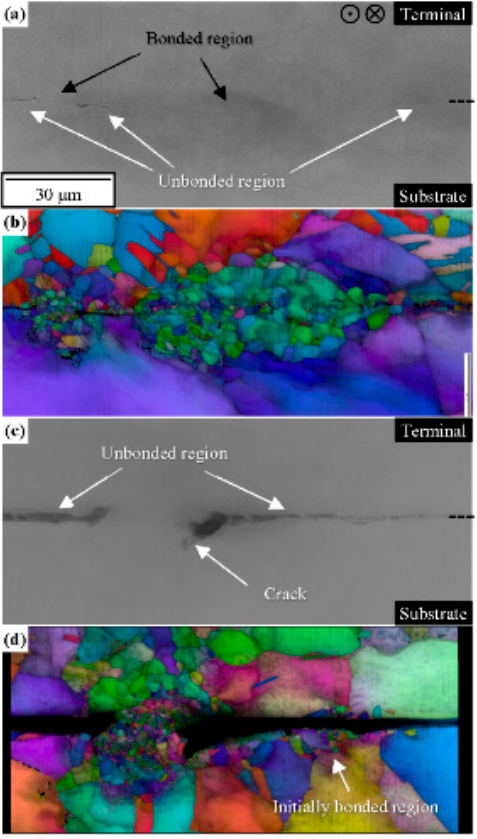
Figure 6. Electron backscatter diffraction (EBSD) results of the cross-section of C1020 joints perpendicular to the ultrasonic vibration. ( a , c ) SEM images and ( b , d ) image quality (IQ) + inverse pole figure (IPF) maps of the joints before and after thermal cycling tests, respectively.